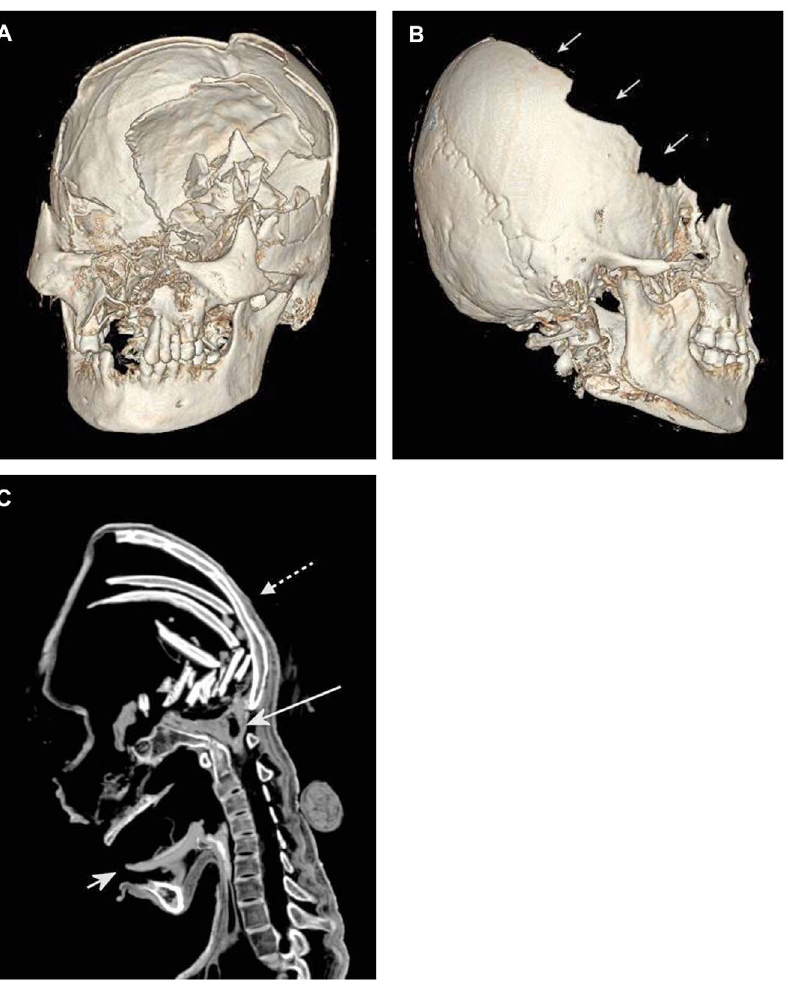
Figure 4. Paleoradiology – Signs of massive craniocerebral injury. ( A, B ) Three-dimensional reconstructions of the head illustrating destruction of the upper and frontal parts of the skull as well as the midface. On the right side ‘‘terrace-like’’, slightly arching defects of the skull are discernible (arrows in B). ( C ) Sagittal CT reformation image of the head and neck showing numerous bony fragments inside the skull, and in between remnants of brain tissue and possibly of bleeding which accumulated especially in the posterior fossa and foramen magnum (long arrow). Preserved tongue (short arrow) with centrally overlying light seam, presumably representing remnants of bleeding. Note the conspicuous flattening of the preserved occiput (dotted arrow) indicating artificial deformity in the lifetime of the mummy.